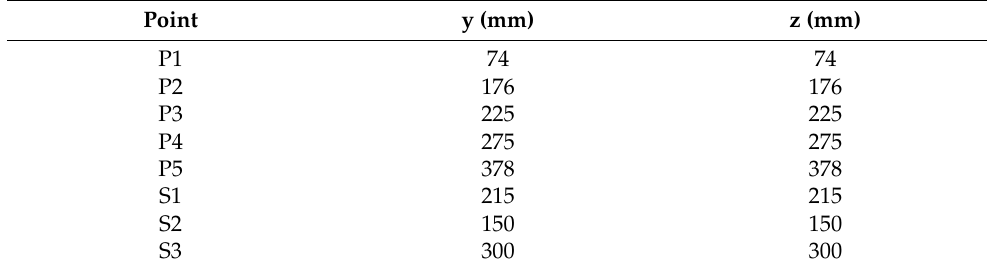
Table 2. Coordinate position of measurement